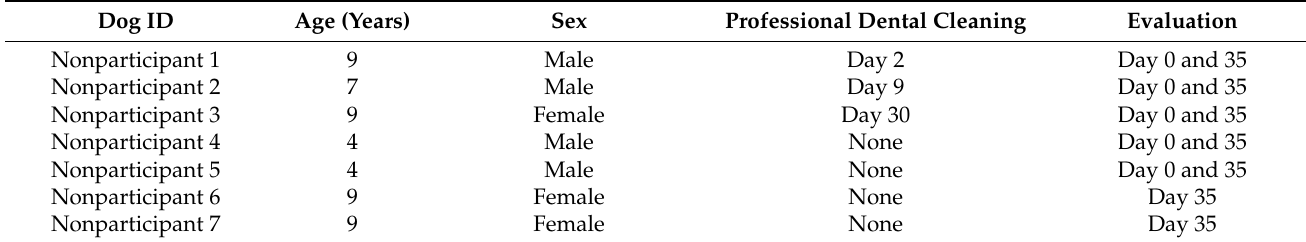
Table 2. Additional dogs used to blind